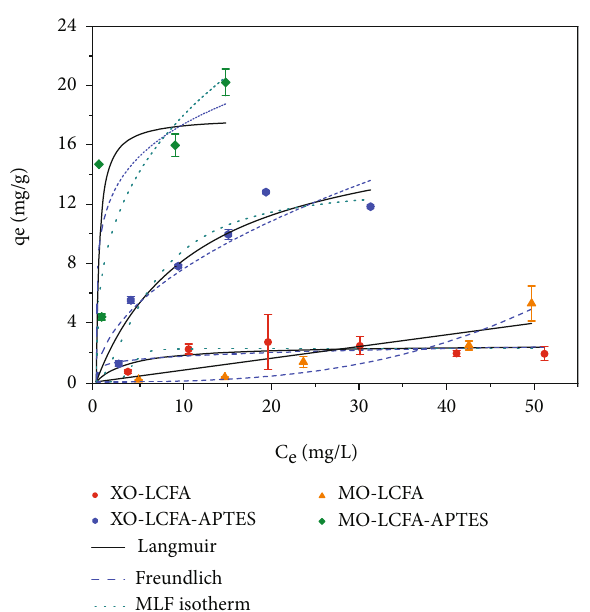
Figure 7: Adsorption isotherms and nonlinear curve fi ts of Langmuir (black solid line), Freundlich (blue dash line), and MLF (black dots)) for XO-LCAFA (red circle), XO-LCFA APTES (blue hexagon), MO-LCFA (orange triangle), and MO-LCFA APTES (green diamond), respectively. The error bars show the standard deviation of at least three repeated measurements.